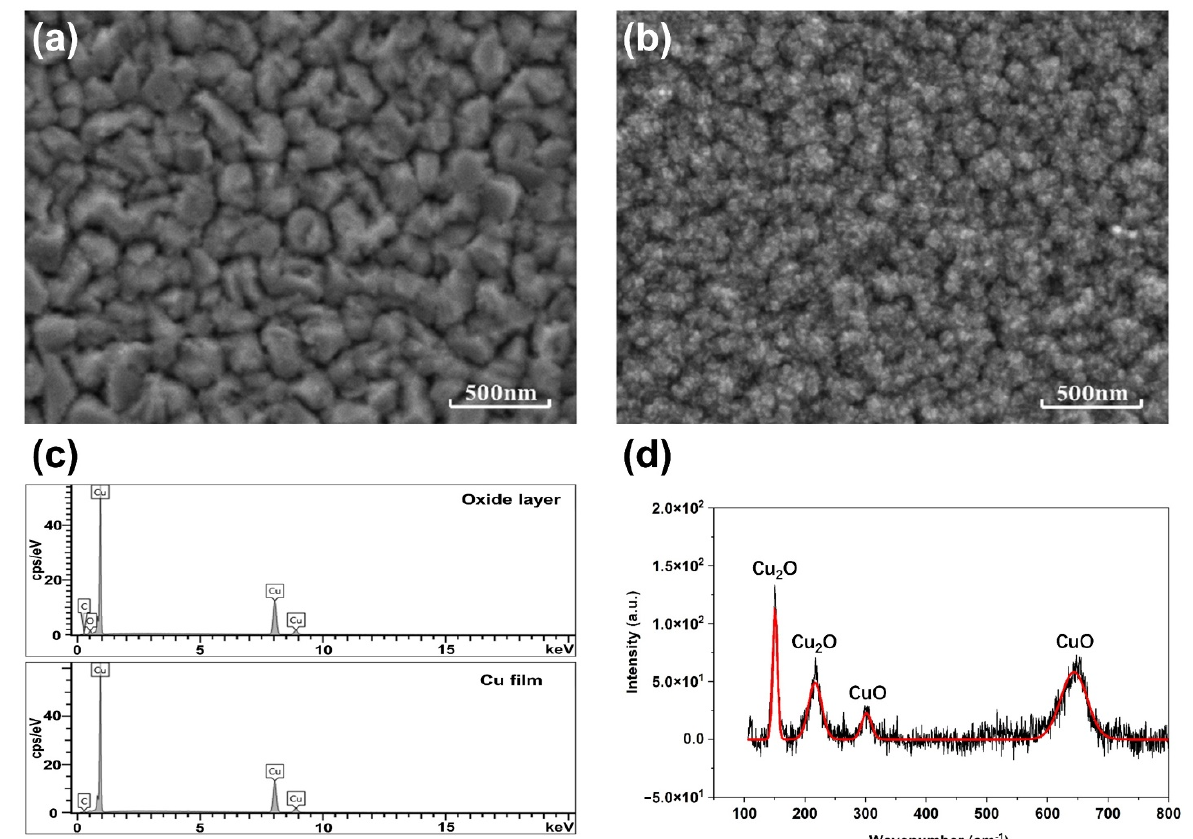
Figure 4. Scanning electron microscope (SEM) images of surface morphology of ( a ) the Cu film and ( b ) the copper oxide layer. ( c ) EDS spectra of the Cu film and the copper oxide layer. ( d ) Raman spectrum of the copper oxide layer.